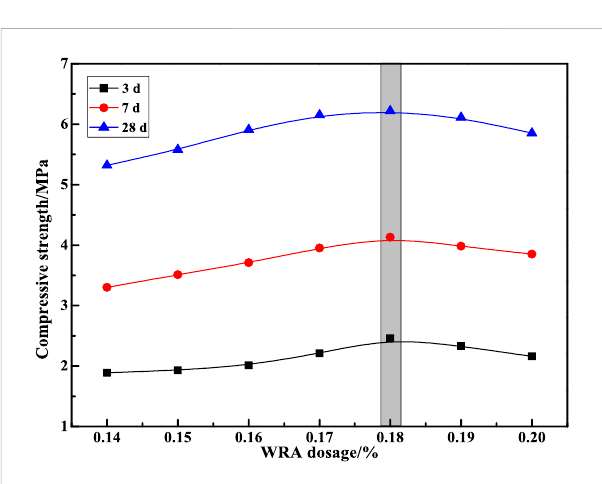
FIGURE 7 Effect of WRA dosage on the mechanical properties of BFPBM at different curing